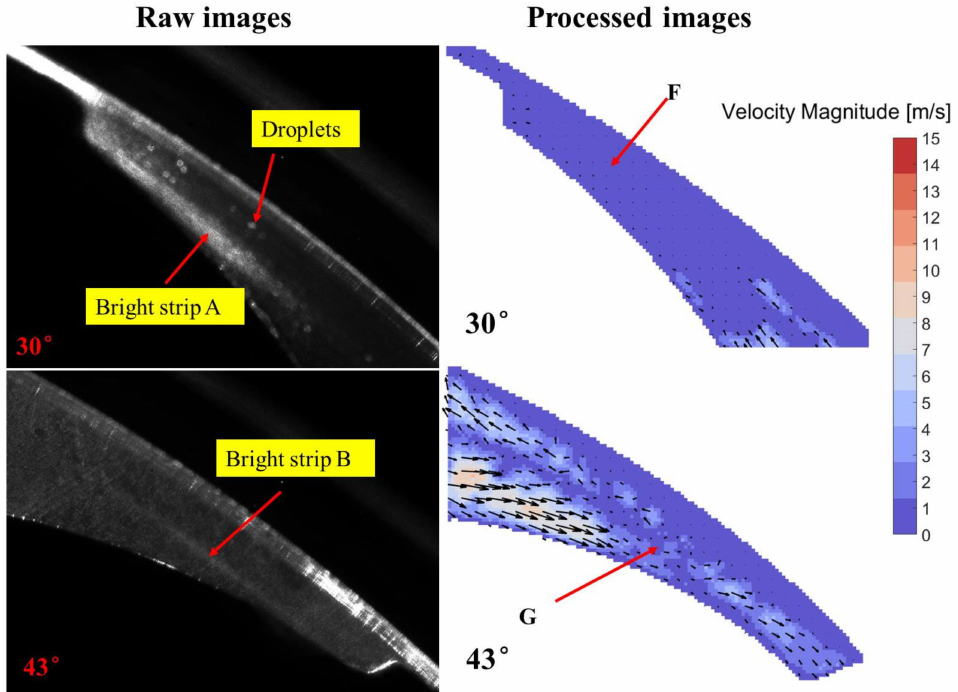
Figure 8. The raw and processed images under the pressure ratio of